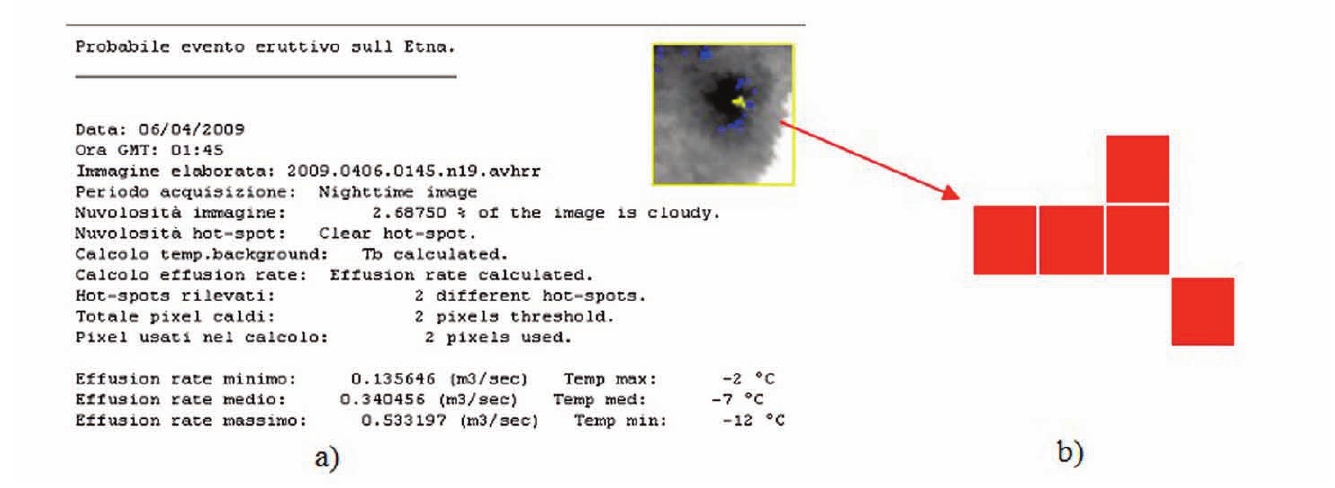
Figure 12. Example of alert message. (a) Text message, and (b) image and number of pixels